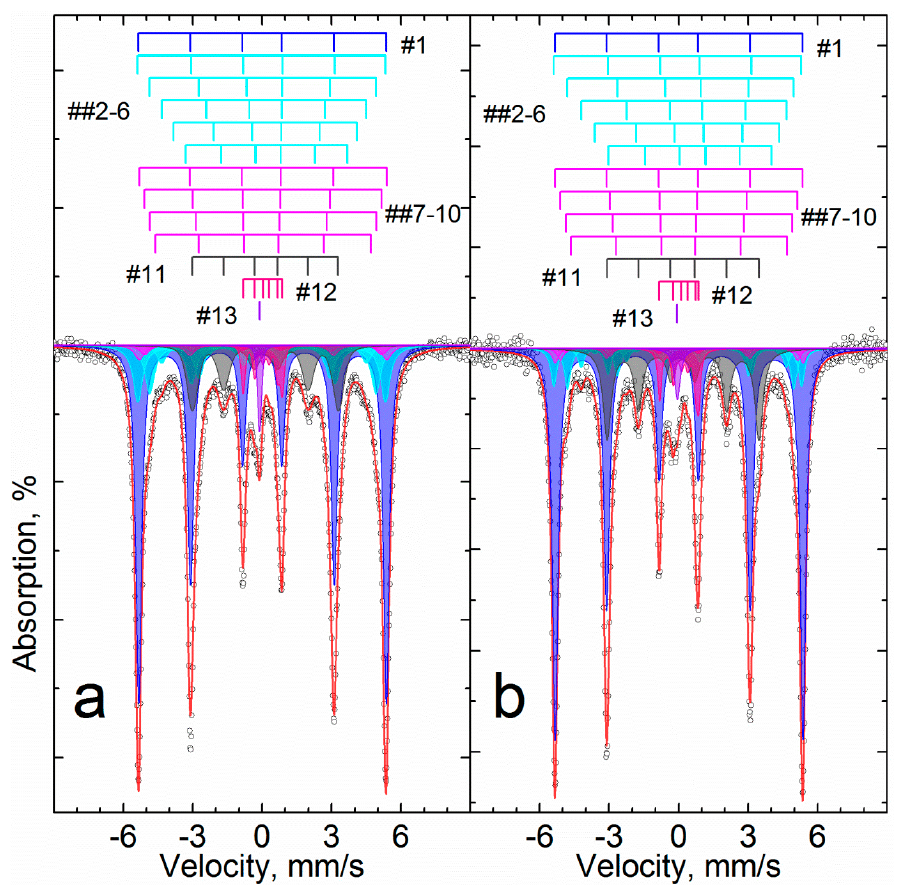
Figure 6. Mössbauer spectra obtained at 296 K of the roasted red mud samples U ( a ) and B ( b ) at 1150 °C during 180 min with addition of 13.65% Na 2 SO 4 and their model description with numbering of subspectra according to Table 3. Table 3. Mössbauer spectra parameters and iron phase distribution in the roasted red mud samples B and U at 1150 °C with addition of 13.65% N a2 SO 4 , where δ —chemical shift; Δ = 2 ε —quadrupole splitting; Г exp —line width; H eff —hyperfine magnetic field; S—site # area.